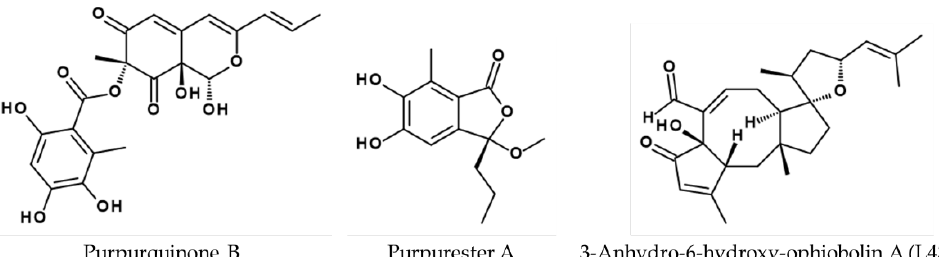
Figure 6. Structures of purpurquinone B [108], purpurester A [108], and 3-anhydro-6-hydroxy-ophiobolin A (L435-3) [114] derived from fungi with high in vitro and in vivo efficacy against A/WSN/33 infection.